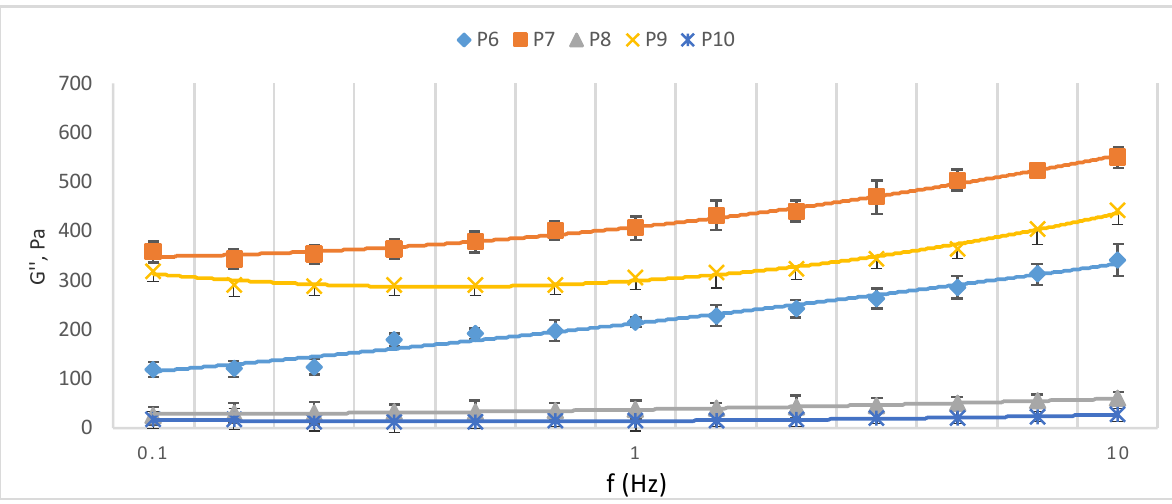
Figure 4. Viscoelastic parameters (G '' ) from frequency of yogurts, series